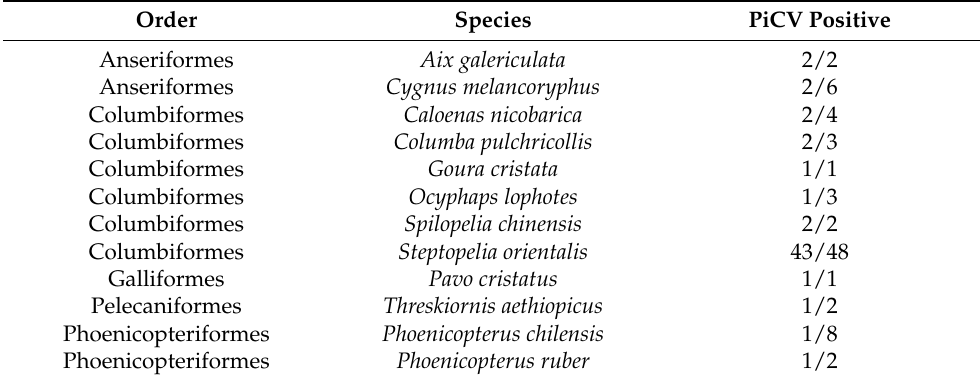
Table 3. The summary of PiCV-positive cases in the present study.